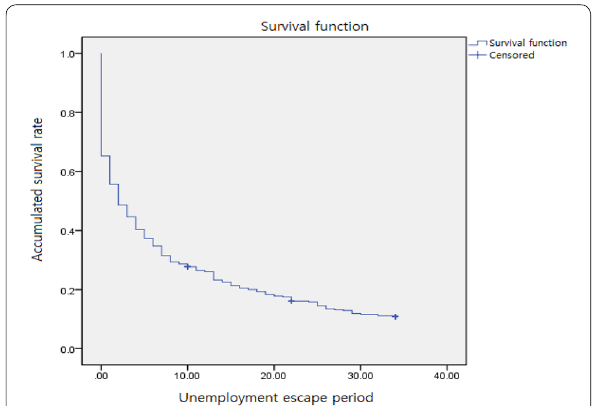
Table 5 Estimated average and median of college